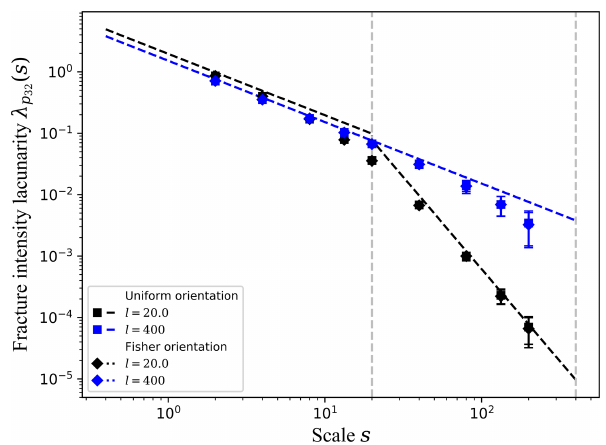
Figure 2. Theoretical (dash) and experimental (dots) p 10 lacunar- ity curves for fracture network sets (3–6) following power-law size distribution at bulk density p 32 = 0 . 5.